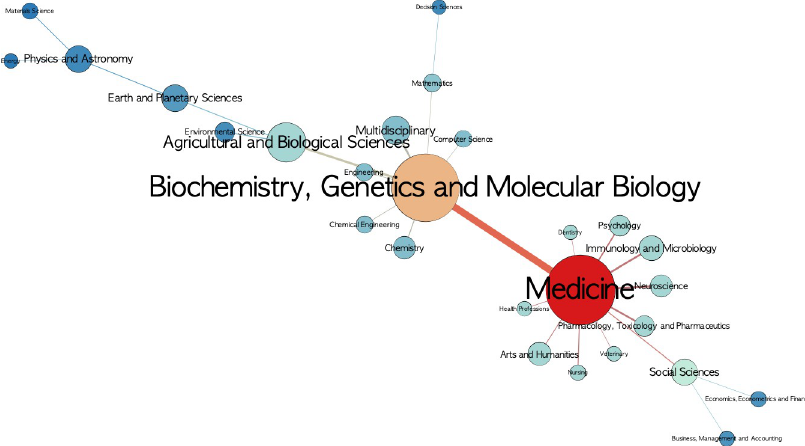
Fig 10. Co-citation network of the 27 main fields after applying the Pathfinder algorithm. The nodes represent each main field; node size corresponds to the total number of citations received, color corresponds to own vector centrality; and the thickness of the edges corresponds with degree of